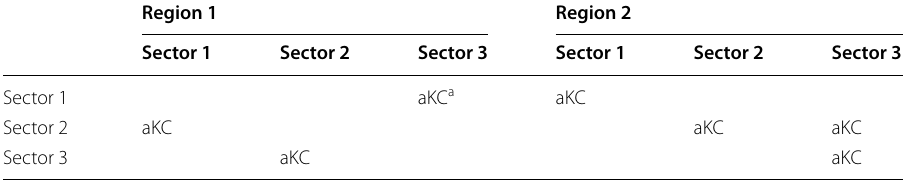
a Aberrant KCs are marked by notation aKC